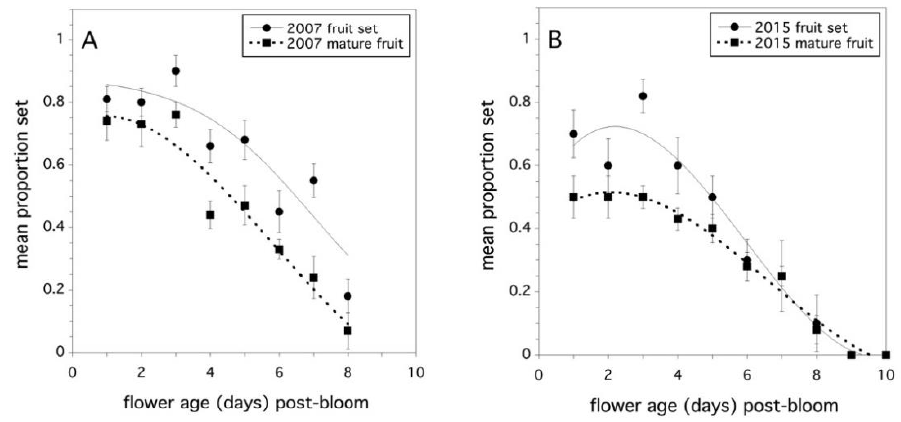
Figure 3. Relationship between the proportion fruit set (solid line) and the proportion mature fruit (dotted line), and the flower age in days post-bloom. ( A ) 2007 and ( B ) 2015. Error bars are standard errors of the clone mean.